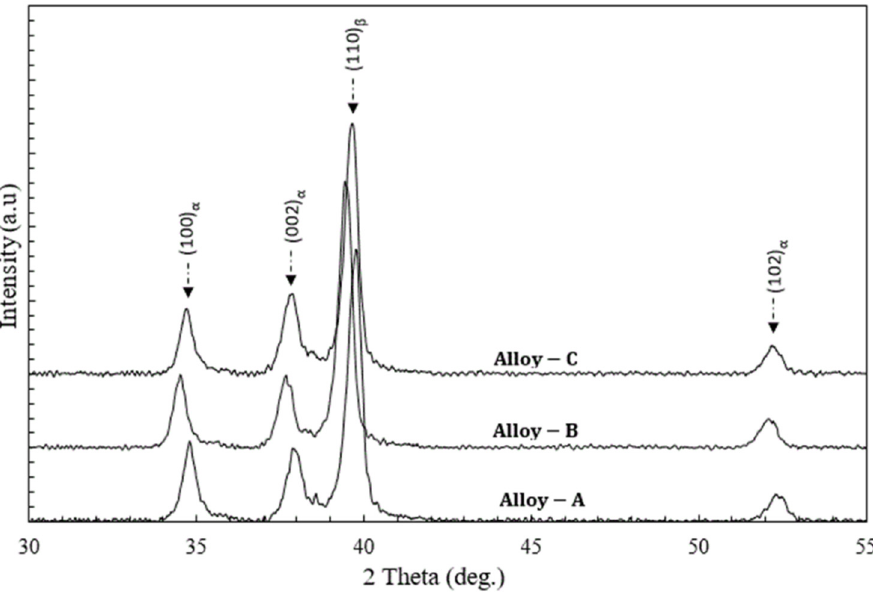
Figure 2. XRD patterns of the experimental alloys fabricated by high-pressure spark plasma sintering (HFIHS) procedure.